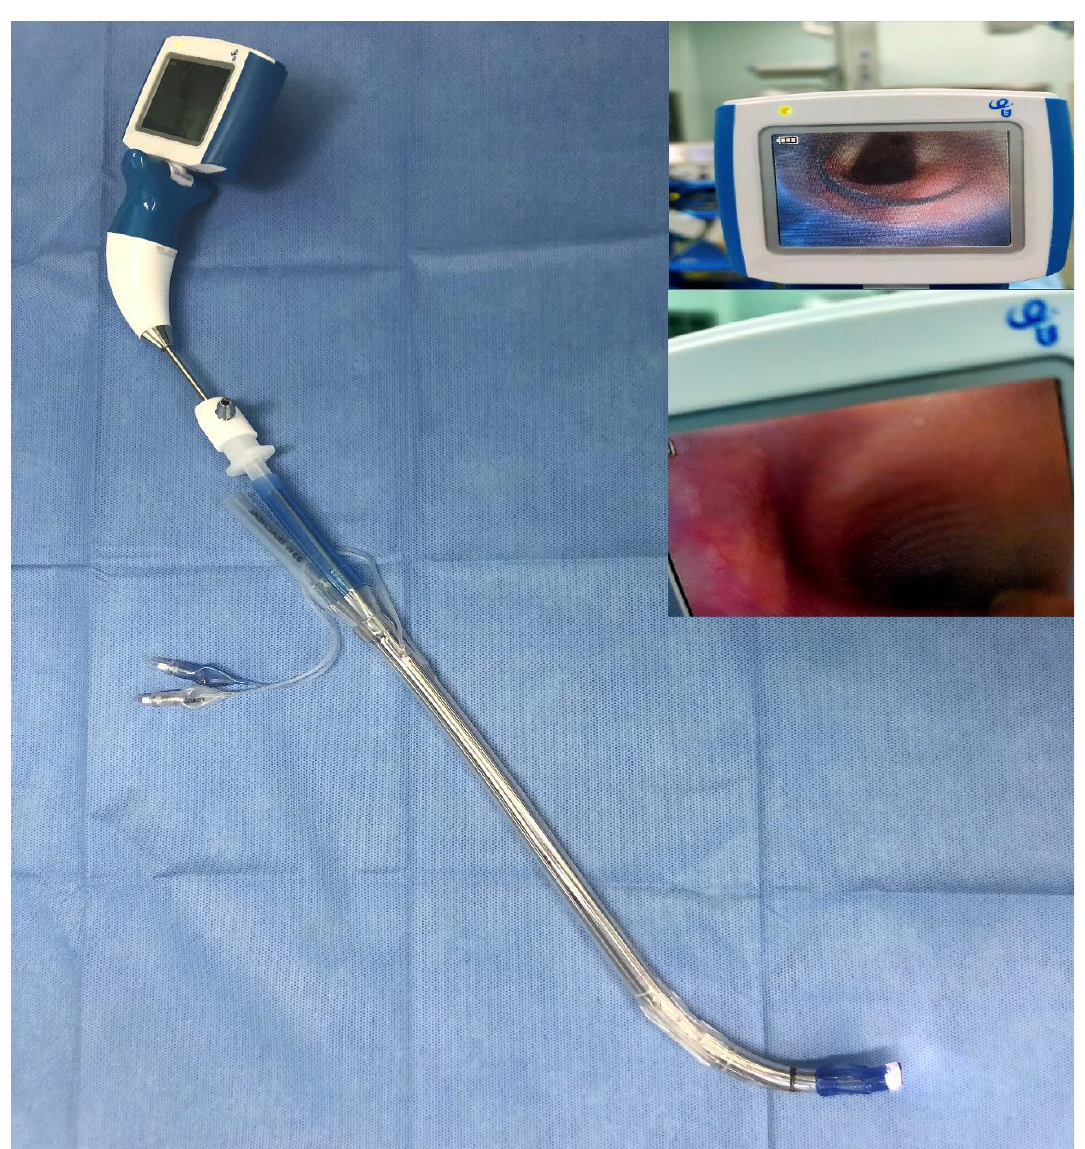
Figure 1. Prepared RVS with stylet in a DLT: real-time view of glottis and after endobronchial cuff passing through the glottis. Abbreviations: RVS, rigid video stylet; DLT, double-lumen endobron- chial tube.